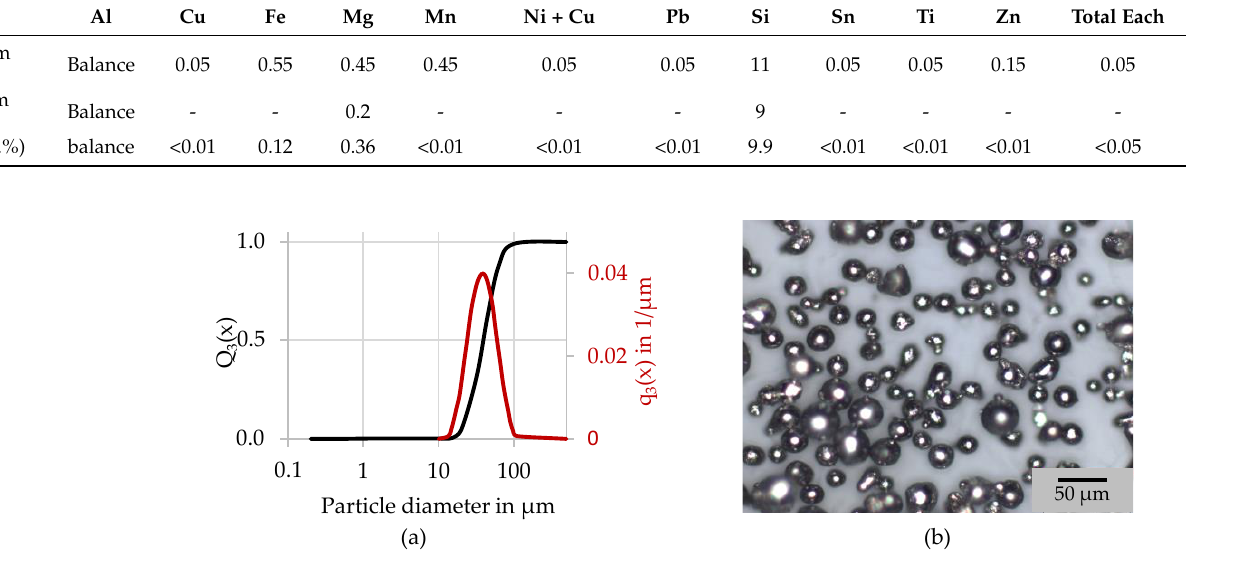
Figure 2. ( a ) Particle size distribution, ( b ) light microscope image of the particle form [16].